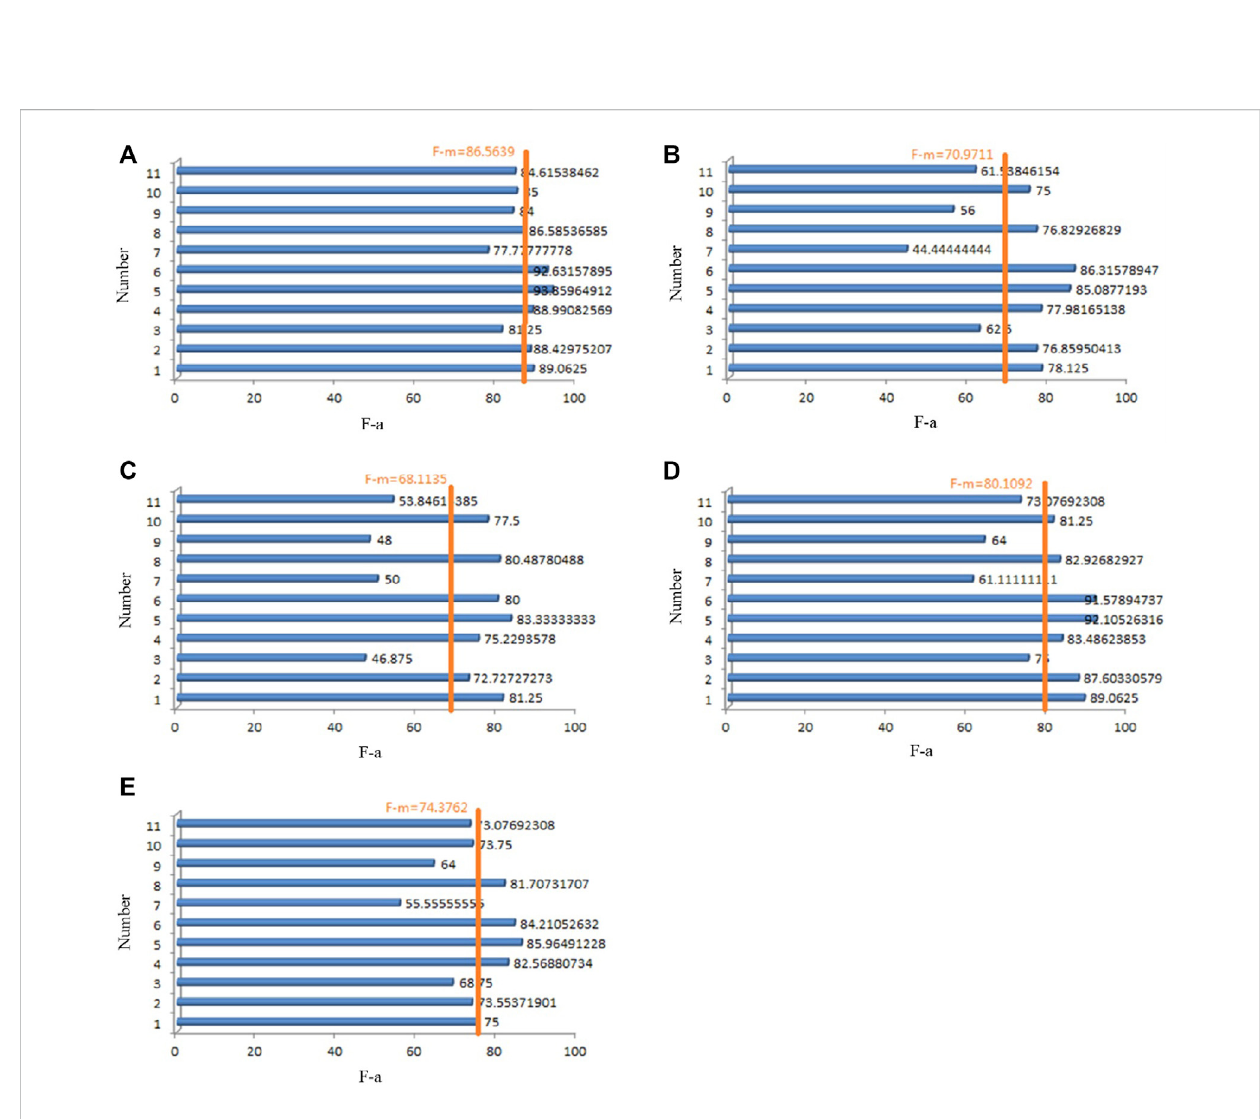
FIGURE 4 Identi fi cation results of different algorithms in the training set. (A) MSAM; (B) HMM; (C) Clustering; (D) V-I trajectory; (E)